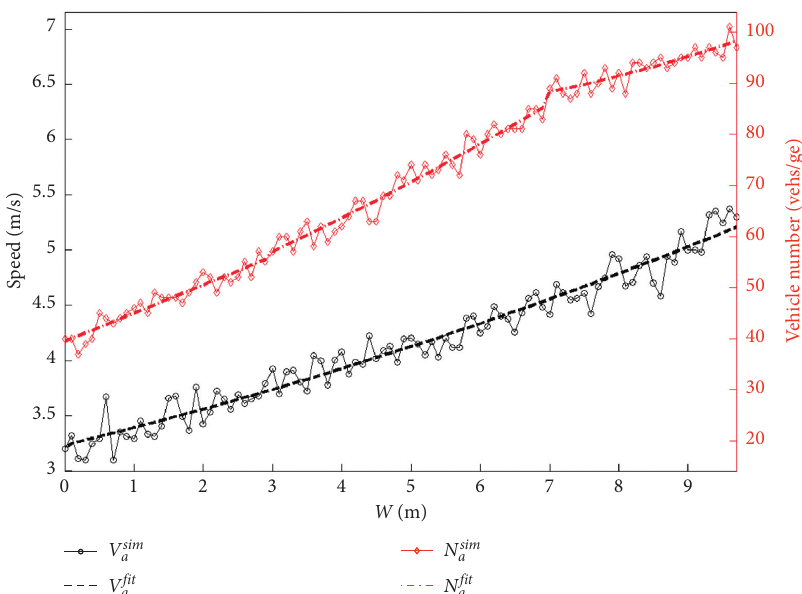
Figure 5: Diagrams under different W of the straddling work zone intersection. Figure 6(b), from the initial state, the length of the work zone D � 0, that is, the lower part, is fully closed. The numbers of approach lanes and exit lanes in the work zone are 2, and the number of non-motor-vehicle lanes is 1, so there are 3 lanes in one direction. When 0 ≤ D < 6.5 m, the half of the road is